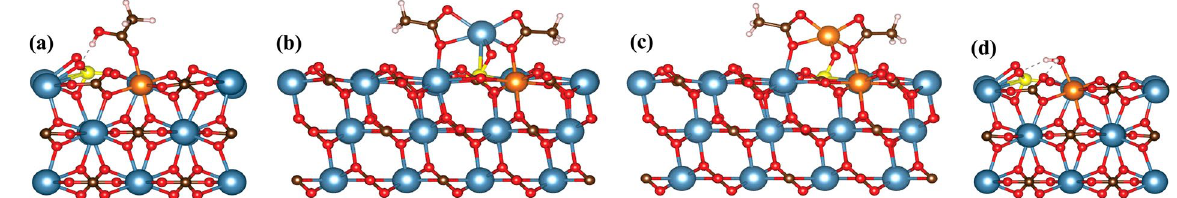
Figure 5. The atomic structures of acetic acid, Ca acetate, Mg acetate and water molecule on modified calcite. MgSO 4 surface.